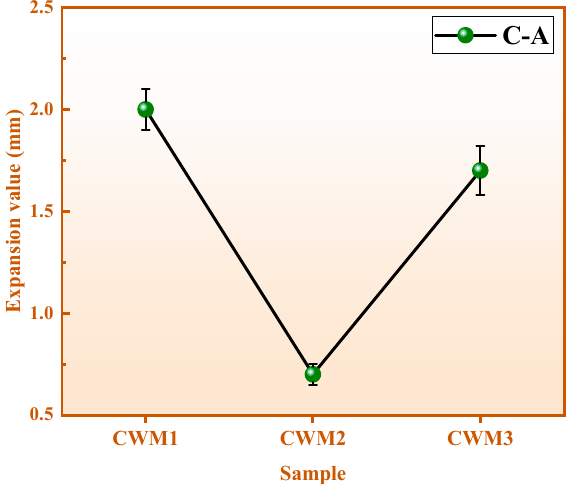
Figure 6. Expansion value of three CWMs.